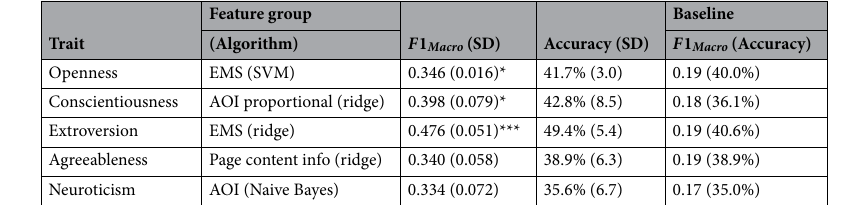
Table 5. Best classifier performance statistics for each personality trait. *p < 0.05, **p < 0.01, ***p < 0.001. AOI Area of Interest, EMS Eye Movement Statistics, Ridge One-vs-Rest Ridge Classification, KNN K-nearest neighbors, SVM Linear support vector